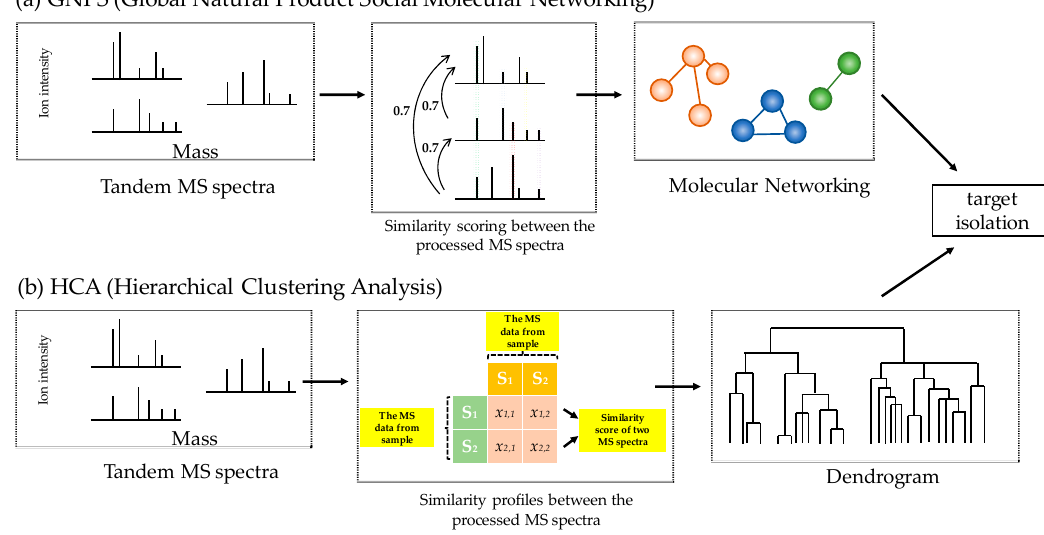
Figure 2. Workflow of molecular networking and hierarchical clustering analysis (HCA). MS spectral data from Trachelospermum asiaticum were acquired by high-resolution mass spectrometry (See Materials and Methods section) and preprocessed by the MZmine software (Version. 2.34). The molecular network was constructed using the Global Natural Product Social Molecular Networking (GNPS) platform. The processed MS spectra with similar patterns (cosine similarity >0.7) were grouped into clusters ( a ). The matrix profile was generated using similarity scores between the processed MS spectra which were calculated by the Pearson correlation coefficient and visualized in a dendrogram ( b ).